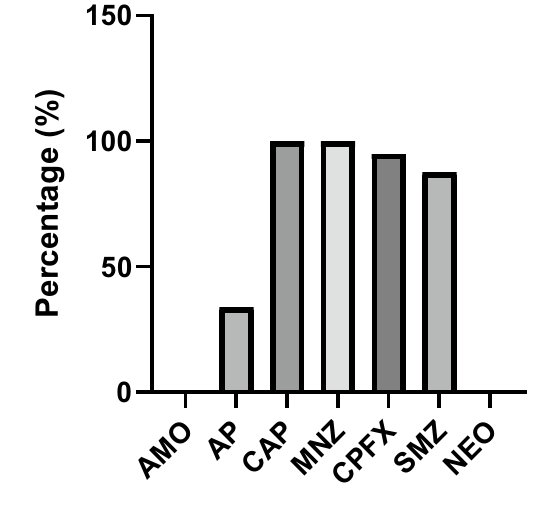
Fig. 3 Frequencies of detection of antibiotic residues